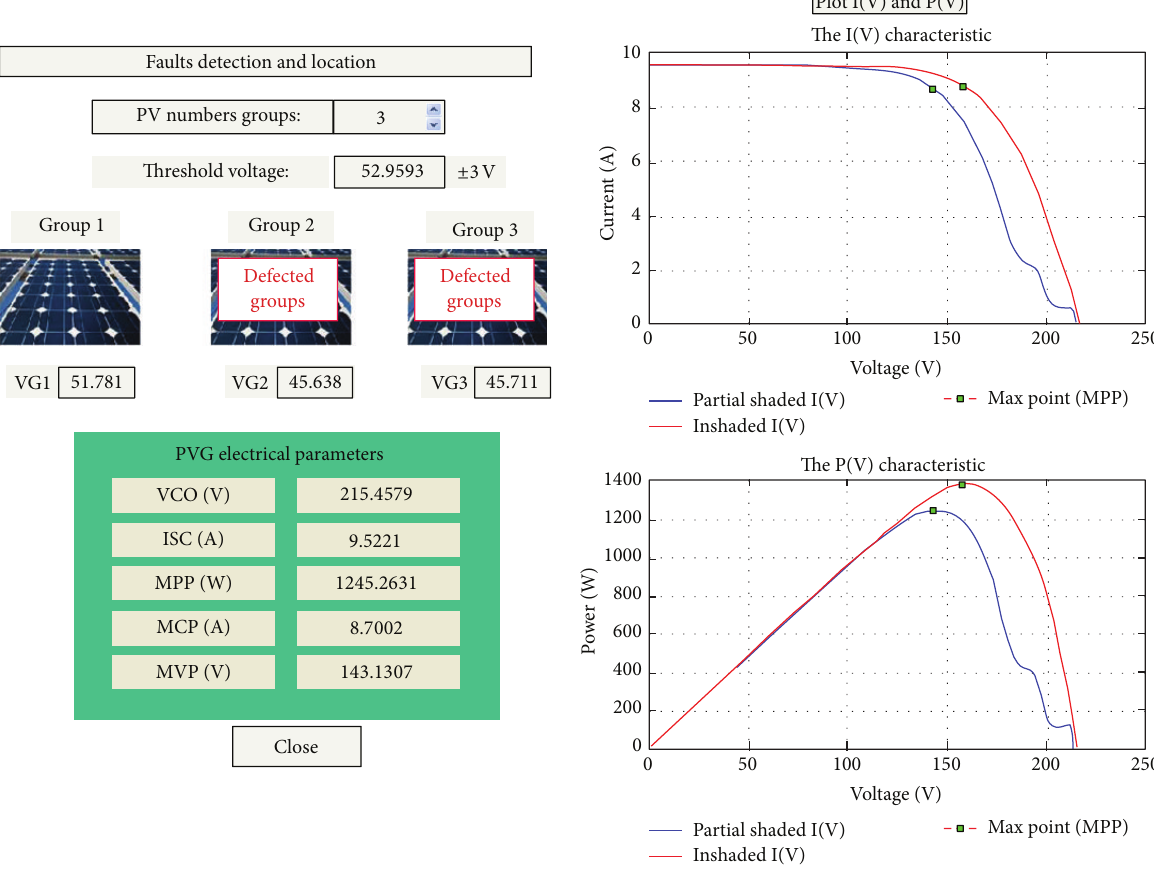
Figure 11: Screenshot of the GUI in case of partial shading in G2 and